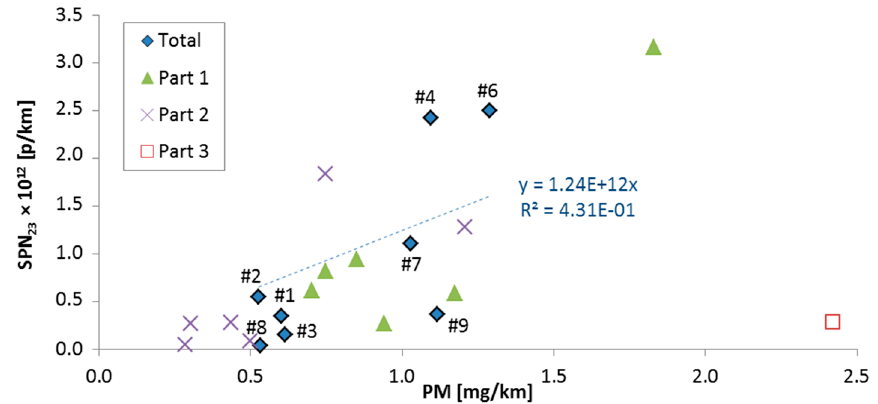
Figure 7. Correlation of particulate matter (PM) mass and solid particle number (SPN) emissions (>23 nm). The cycle tested was the WMTC (Figure 2) with the Euro 5 weighting factors of Table